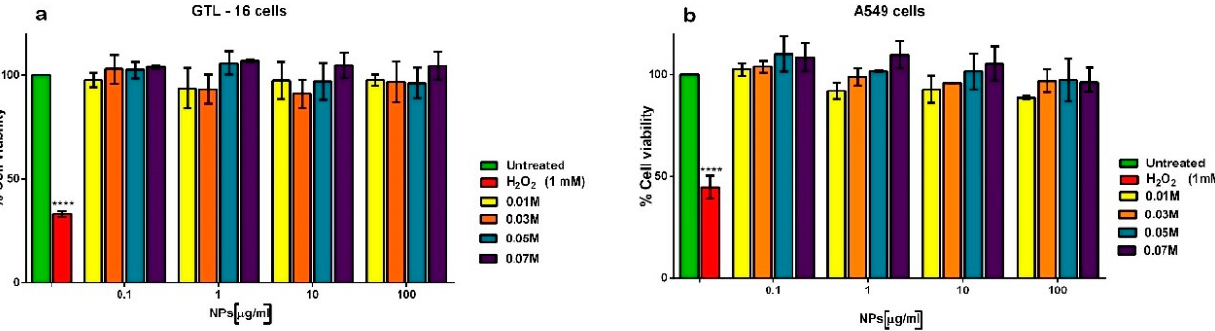
Figure 8. Viability of GTL-16 cells ( a ) and of A549 cells ( b ) incubated with cit-Ca 2+ :TbPO 4 · nH 2 O particles prepared with different Ca 2+ -doping concentration for three days. Viability was assessed in MTT assays. Data represent means ± SD of three independent experiments performed in triplicate and statistical analyses were carried on using One-way ANOVA, with Bonferroni comparison test. For statistical analysis all data were compared to untreated samples and only samples treated with H 2 O 2 displayed statistically significant difference (**** p = 0.0005).